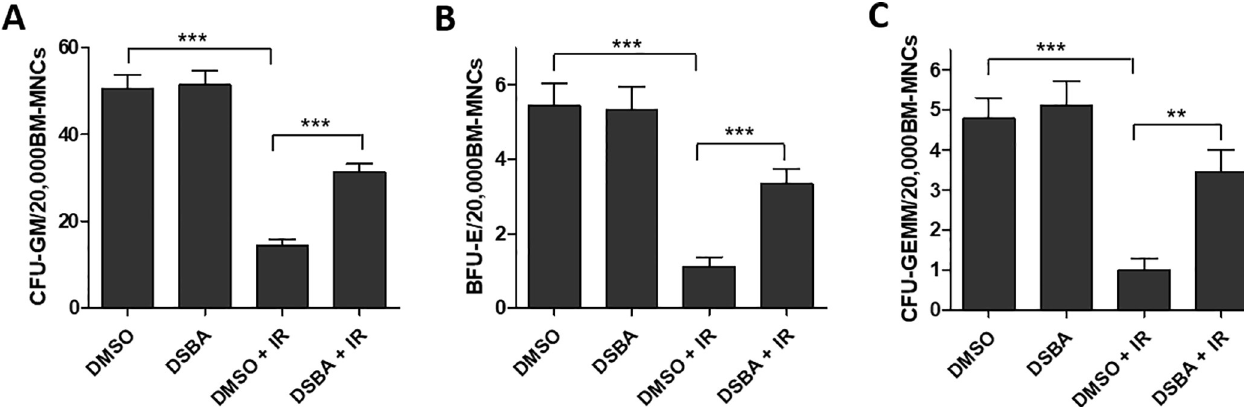
Fig 6. DSBA pre-treatment protects mouse BM HSPCs against ionizing radiation (IR)-induced injury in vivo. The clonogenic function of HSPCs was measured using CFU assays (12). average number of (A) CFU-GM, (B) BFU-E and (C) CFU-GEMM in 20,000 BM-MNCs. Data are presented as mean ± SEM of three independent experiments (N = 3; n = 3 mice). �� p < 0.01. ��� p <